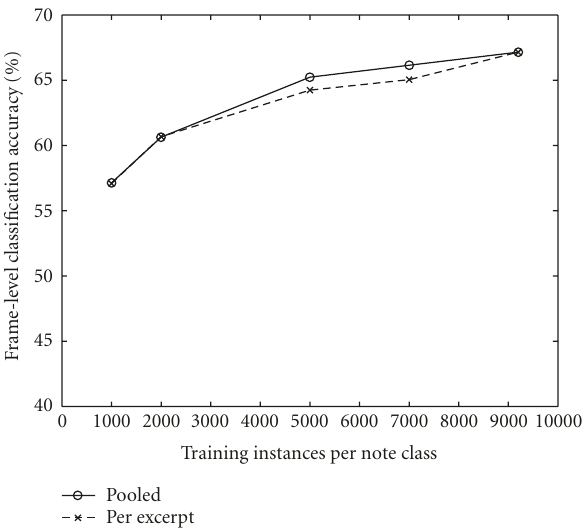
Figure 4: (a) Posteriorgram (pitch probabilities as a function of time) for an excerpt of Beethoven’s F¨ur Elise. (b) The HMM smoothed estimation (dark gray) plotted on top of the ground truth labels (light gray; overlaps are